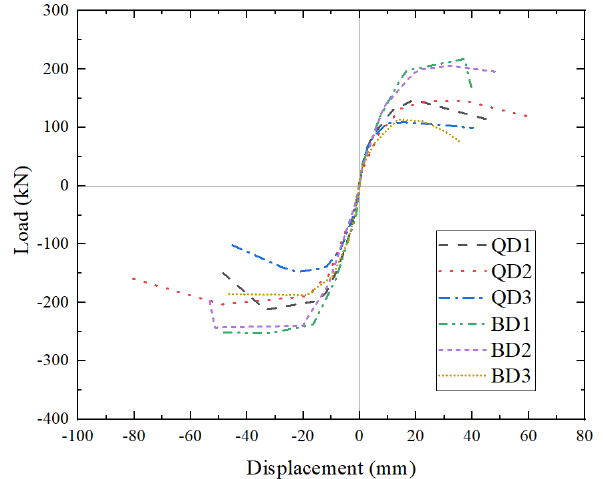
Figure 7. Skeleton Figure 7. Skeleton curves.